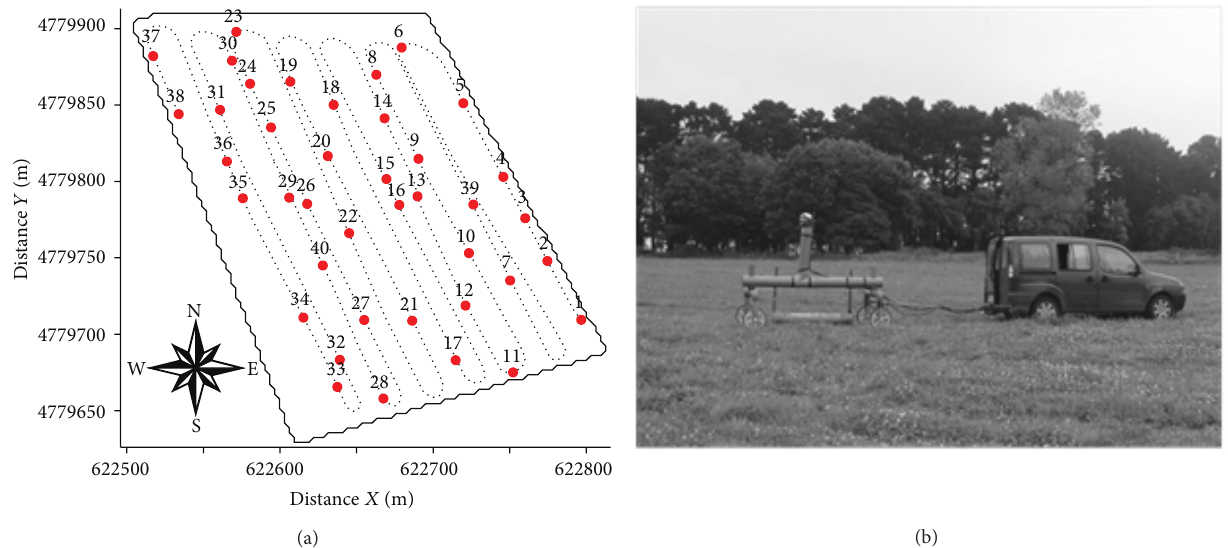
Figure 2: Scheme showing apparent electrical conductivity (EC (circles) on 23/6/2008 (a) and cart containing the EM38-DD equipment and GPS (b).